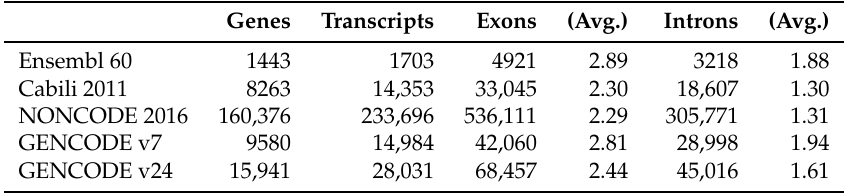
Table 1. Long non-coding RNA (lncRNA) genes catalogued by various annotation systems. The average number of exons and introns per transcript is given in the (avg.)